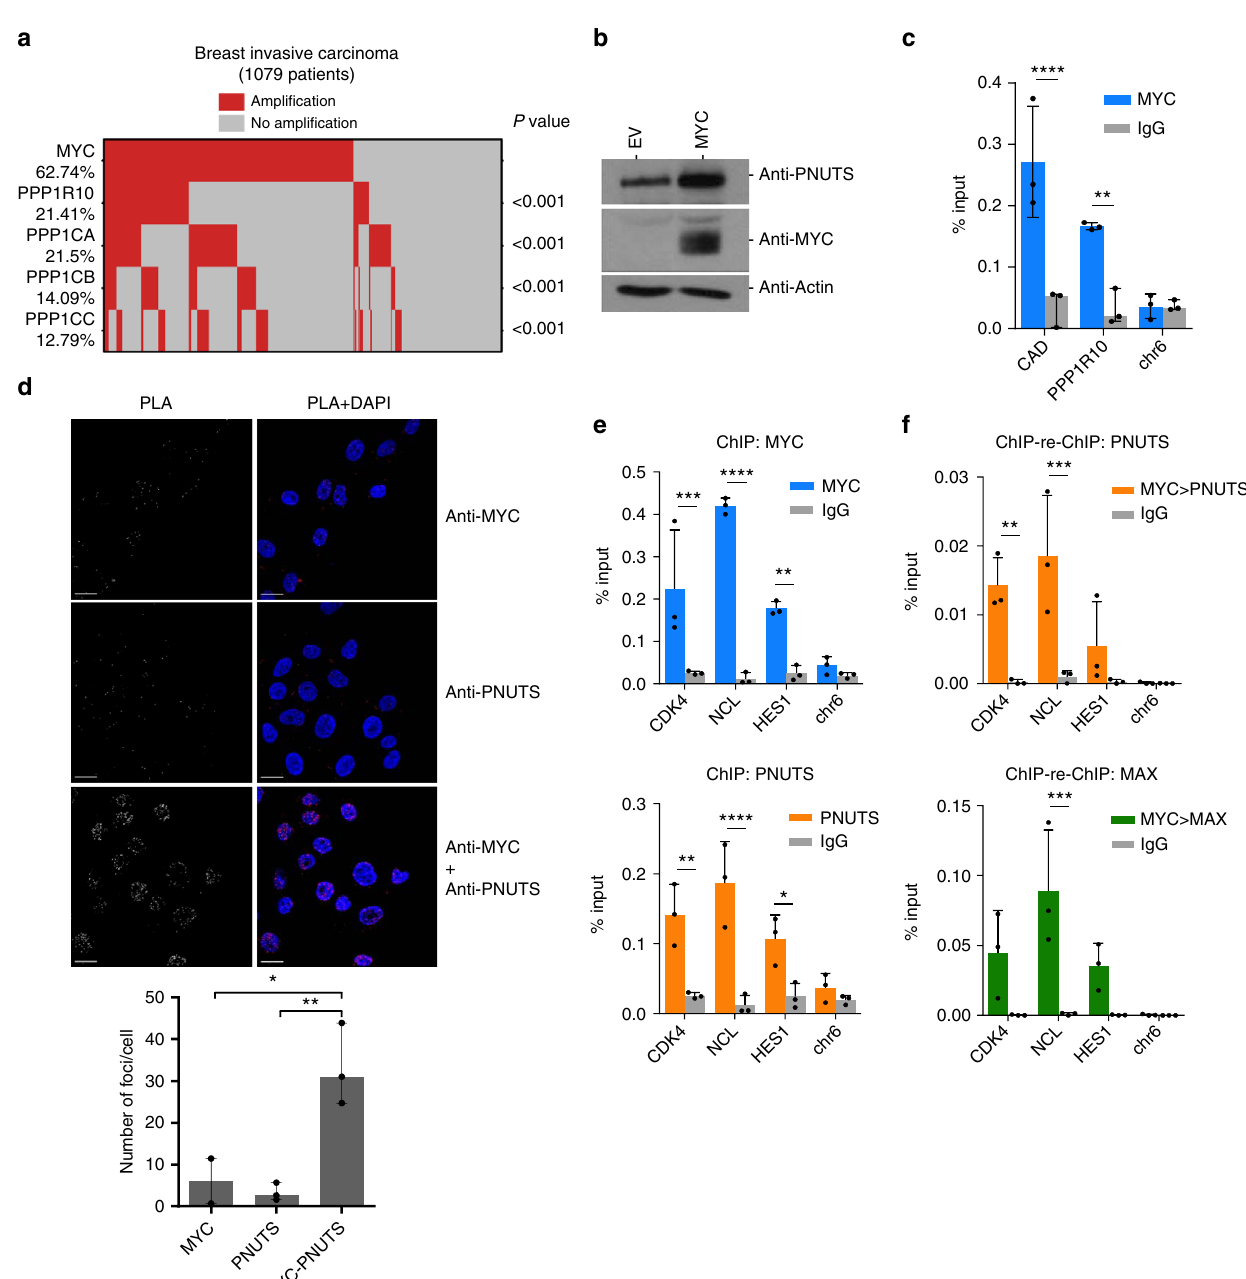
Fig. 2 MYC and PP1/PNUTS are co-ampli fi ed in cancer and co-bind to promoters of MYC target genes. a MYC and PPP1R10 , PPP1CA , PPP1CB , or PPP1CC gene ampli fi cation is evident and demonstrates signi fi cant co-occurrence in breast invasive carcinoma. b HO15.19 MYC knockout cells (EV) or cells ectopically expressing MYC were lysed and immunoblotted with antibodies to PNUTS, MYC, and actin. Shown are representative images of n = 3. c MCF10A cells were analyzed by chromatin immunoprecipitation (ChIP) using MYC or IgG antibody. ChIP ’ d DNA was quanti fi ed by qPCR for MYC or IgG binding to CAD and PPP1R10 promoters or chr6 (negative control). d MCF10A cells probed with MYC rabbit antibody and/or a PNUTS mouse antibody. The proximity of MYC and PNUTS was assayed using the Duolink Proximity Ligation Assay (PLA) In Situ Red Starter kit (Sigma) as per manufacturer ’ s instructions. Representative PLA signal (red or white) and nuclear staining (DAPI; blue) are shown for cells probed with anti-MYC alone (top row), anti- PNUTS alone (middle row), or anti-MYC and anti-PNUTS (bottom row). PLA signal was quanti fi ed and shown as median number of foci per cell with range ( n = 3). * p < 0.05, ** p < 0.01, one-way ANOVA with Bonferroni test. Scale bars represent 20 µ m. e MCF10A cells analyzed by ChIP with MYC, PNUTS or IgG antibody. ChIP ’ d DNA was quanti fi ed using qPCR for MYC, PNUTS or IgG binding to MYC target genes promoters, CDK4, NCL , and HES1 , or chr6 (negative control). f For ChIP-re-ChIP analysis, MCF10A cells lysate incubated with MYC rabbit antibody followed by PNUTS (top panel), or MAX (bottom panel) antibody along with IgG antibody as a control. ChIP ’ d DNA was quanti fi ed similarly as above for ChIP experiment. For c , e , f : shown are % input mean ( n = 3). * p < 0.05, ** p < 0.01, *** p < 0.001, **** p < 0.0001, two-way ANOVA with Bonferroni test. Error bars represent